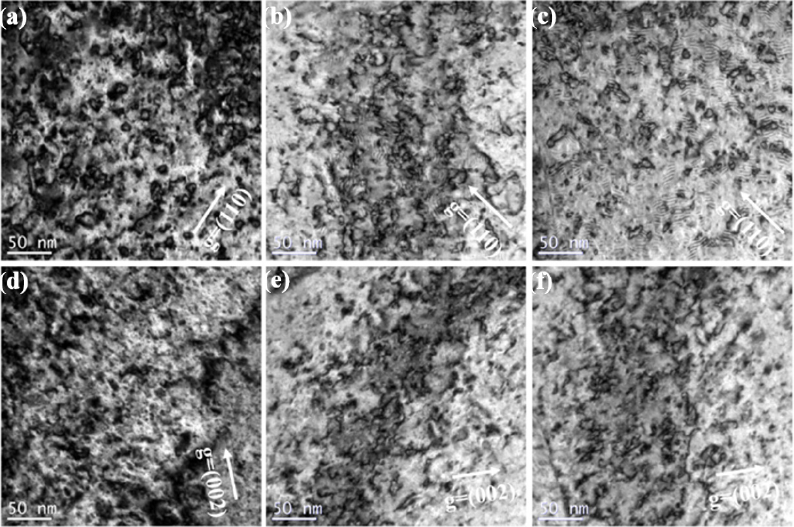
Figure 6. Bright ‐ field TEM images using two beam conditions from the [001] zone axis showing loops in three irradiated W ‐ based materials: ( a ) pure W, ( b ) sintered W ‐ 1.5ZrO 2 composites, ( c ) swaged W ‐ 1.5ZrO 2 composites with g vector of <110>, ( d – f ) corresponding to above three samples with g vector of <002>, respectively.